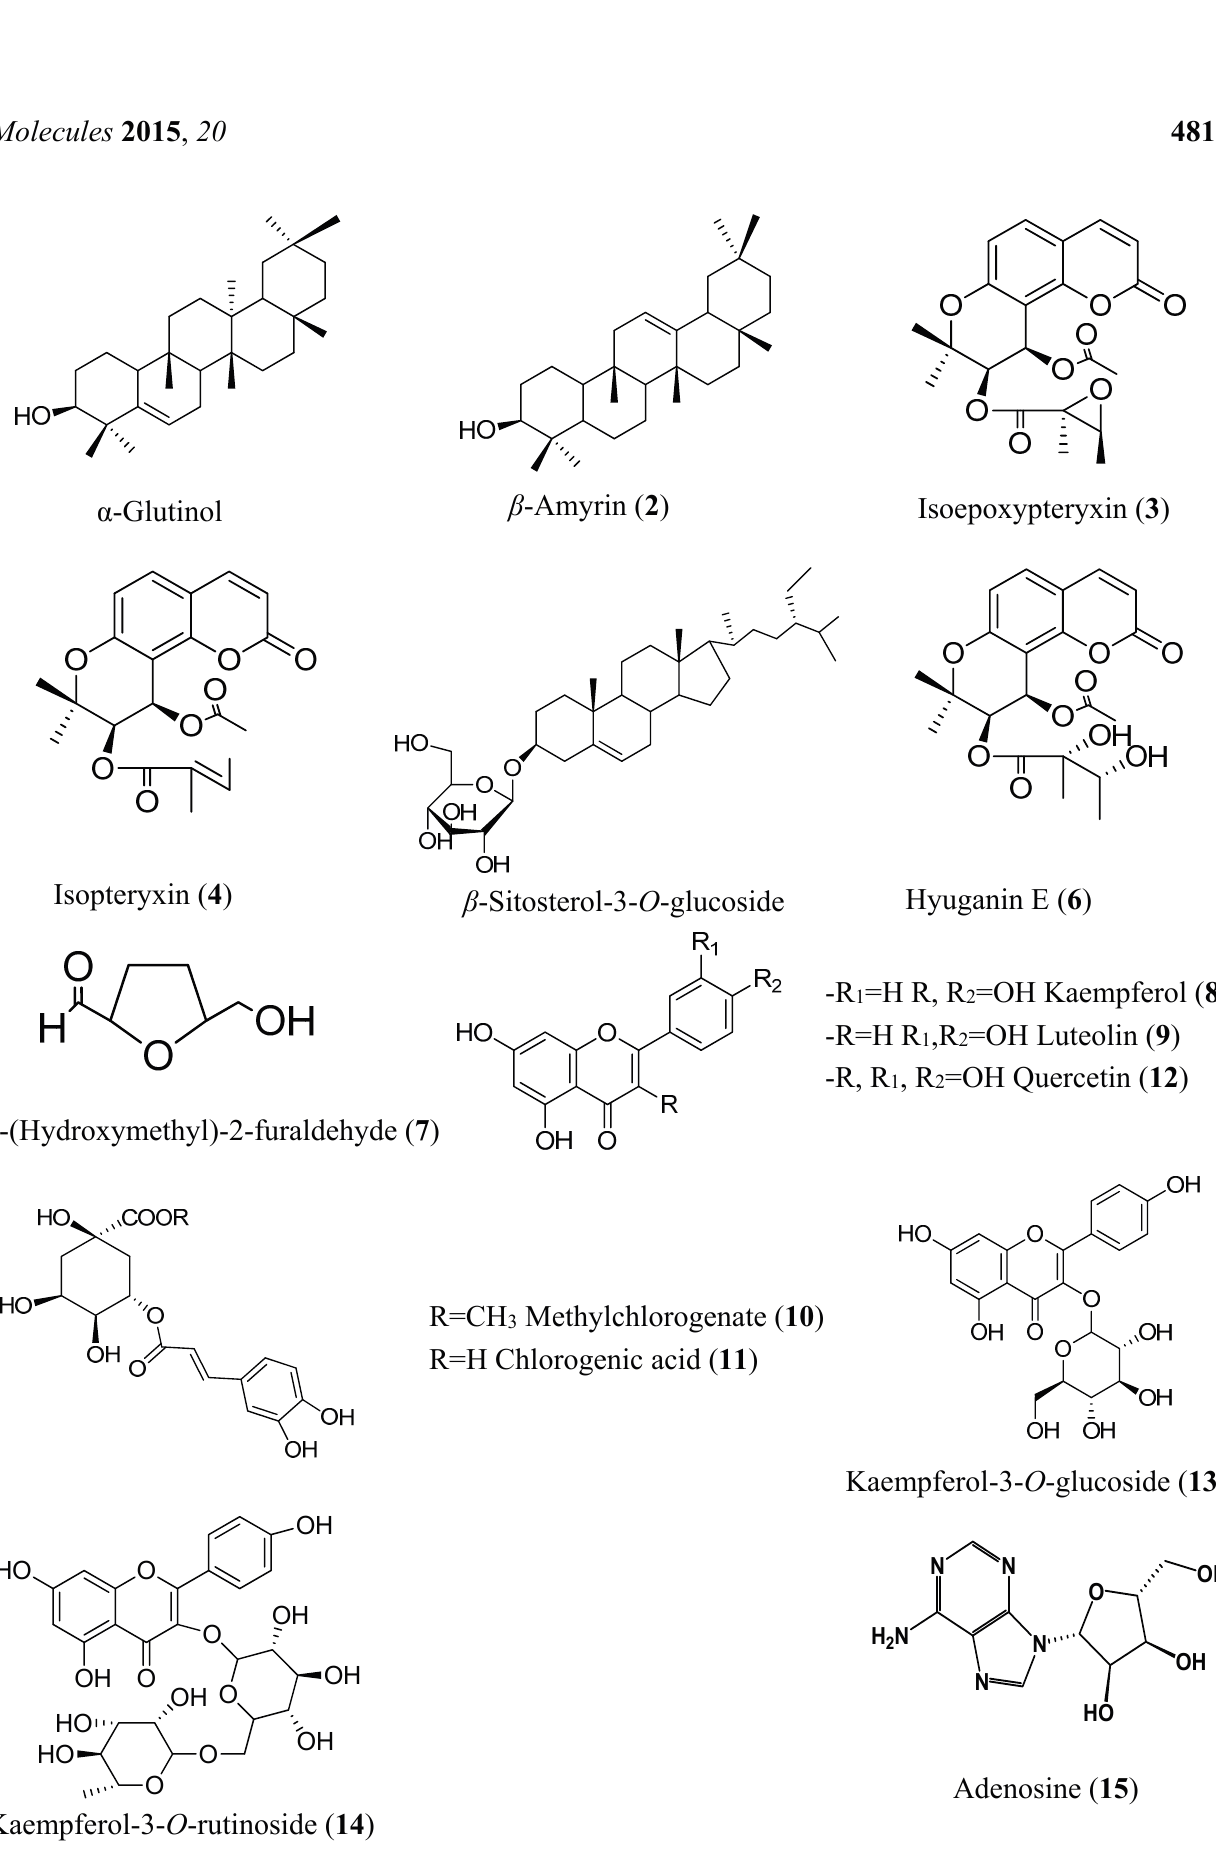
Figure 1. Structures of compounds isolated from the aerial parts of A. shikokiana